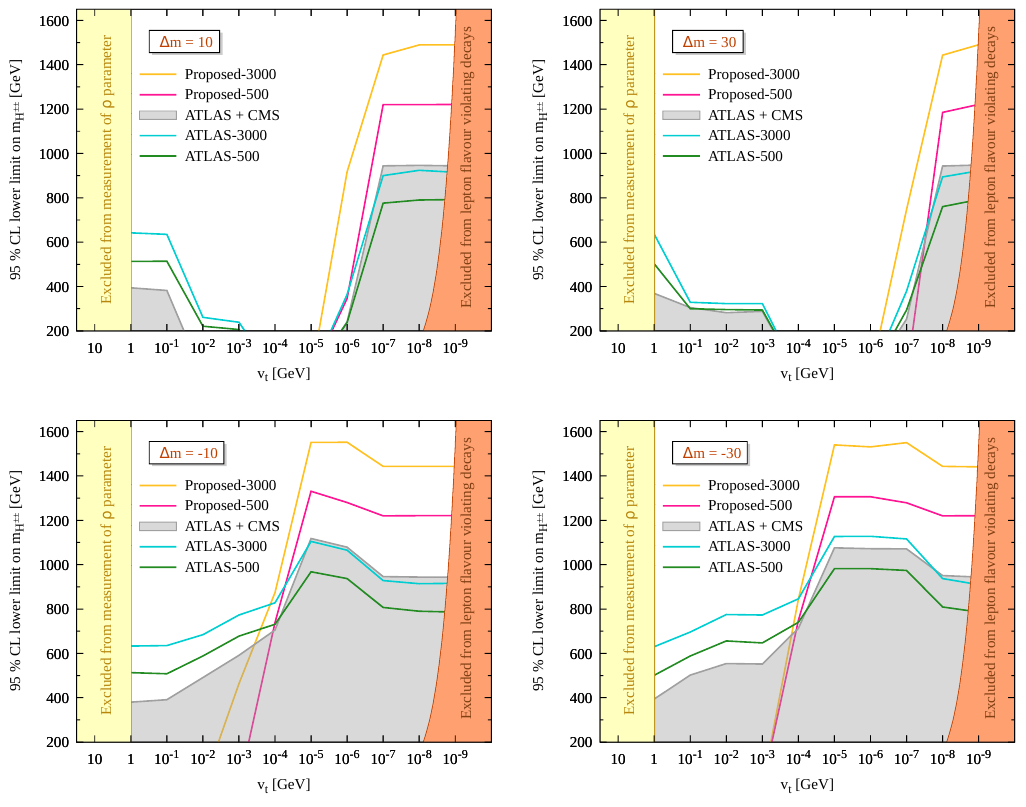
Figure 9 . 95% CL lower limits on m as a function of v t assuming NH with m 1 = 0 . 03 eV H ±± for different values of ∆ m : ∆ m = 10 GeV (top left), ∆ m = 30 GeV (top right), ∆ m = − 10 GeV (bottom left) and ∆ m = − 30 GeV (bottom right). The color codings are same as those in figure 8. For ∆ m = − 10( − 30) GeV and moderate v , the expected reach from our proposed t search extends up to 1330(1310) and 1555(1550) GeV, respectively, at 500 and 3000 fb − 1 of